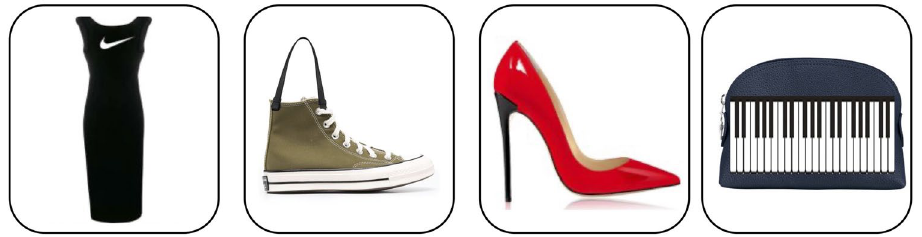
Figure 9. Improbable products. By combining fashion features, brands, and items in new ways, we obtain visually realistic products with clear, zero-shot compositional semantics. From left to right: “Nike long dress”, “converse with handles”, “red shoes with black high heel”, “keyboard